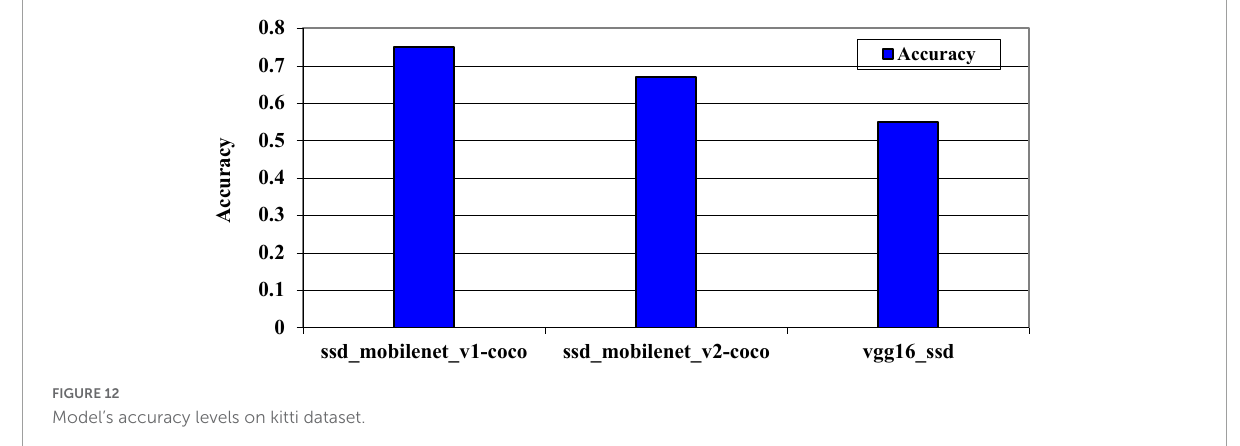
FIGURE12 Model’s accuracy levels on kitti dataset.